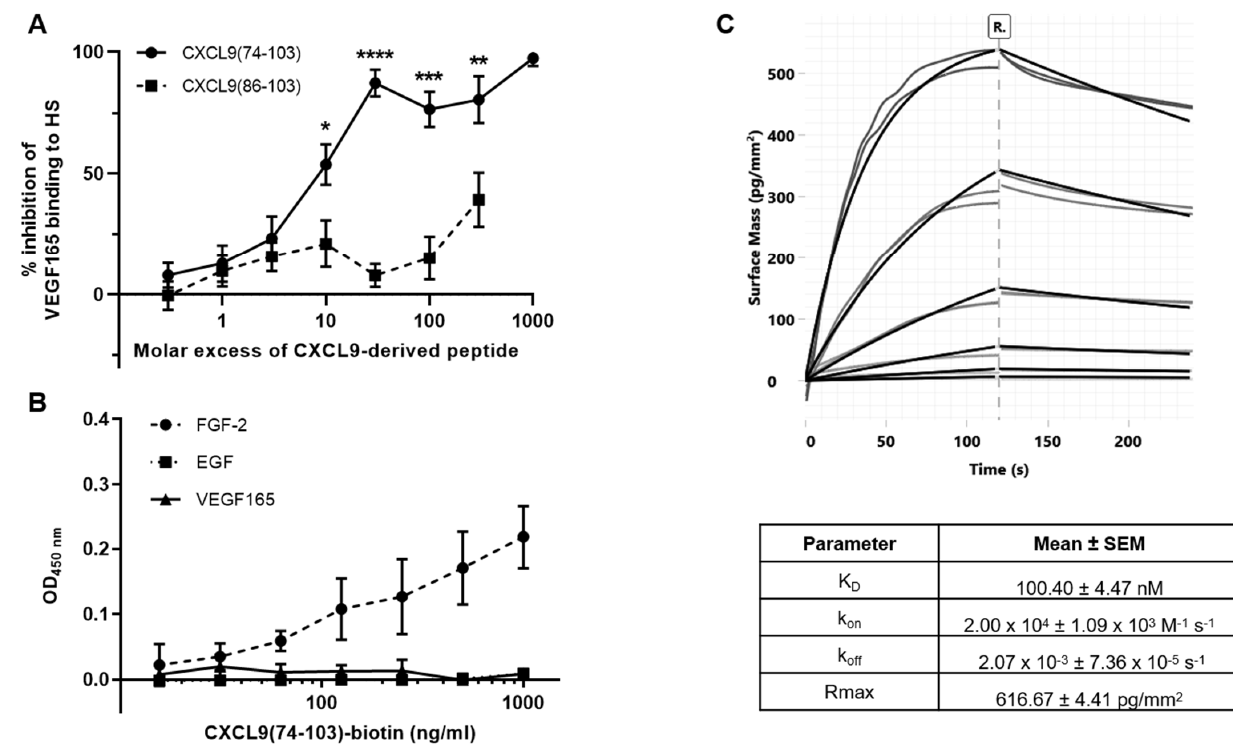
Figure 7. CXCL9(74-103) competes with VEGF165 for HS binding and directly interacts with FGF-2. ( A ) Competition between CXCL9(86-103) and CXCL9(74-103) with VEGF165 for HS binding was examined in an ELISA-like GAG binding assay. Results are expressed as a mean ( ± SEM) percentage inhibition of VEGF165 binding to HS per indicated molar excess of CXCL9-derived peptide. [n = 5; Mann–Whitney U test; * p < 0.05, ** p < 0.01, *** p < 0.001, **** p < 0.0001 [compared to CXCL9(86-103)]]. ( B ) Direct interaction of CXCL9(74-103) with FGF-2, EGF or VEGF165 was determined. Plates were coated with 50 ng/mL growth factor and interaction with CXCL9(74-103)-biotin was detected with streptavidin-HRP. The mean (±SEM) OD value measured at a wavelength of 450 nm for each indicated concentration of CXCL9(74-103)-biotin is shown (n ≥ 2, in duplicate). ( C ) Direct interaction between FGF-2 and CXCL9(74-103) was characterized using grating-coupled interferometry. A representative sensorgram (grey: experimental data; black: data fitting) and a table with the mean kinetic parameters (± SEM) are shown (n = 3). The sensorgram shows binding of a concentration series of FGF-2 (4.53 nM, 13.6 nM, 40.7 nM, 122 nM, 367 nM, 1.10 µM; in duplicate) flown over biotinylated CXCL9(74-103) immobilized on a streptavidin-coated sensorchip. The data are represented as the mass bound to the chip surface (pg/mm 2 ) in function of time (s), using double referencing against a reference channel and blank buffer injections.